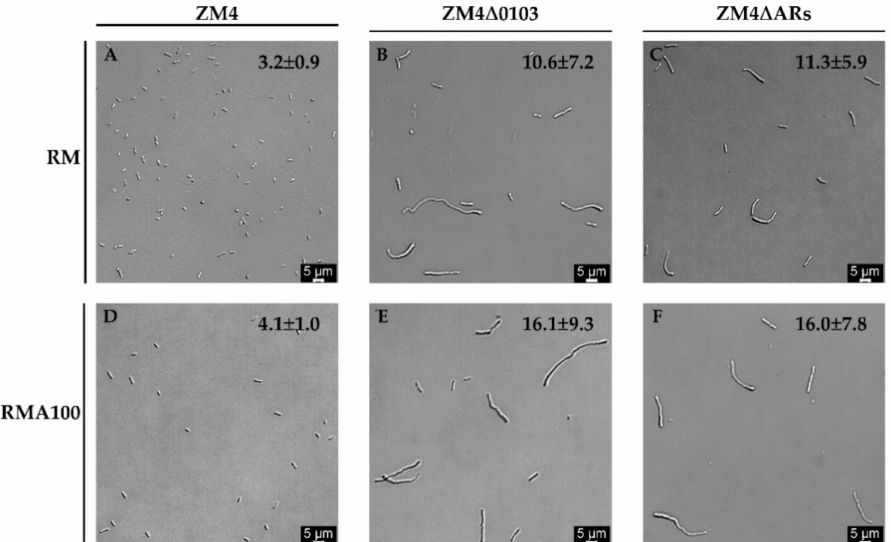
Figure 3. Cell morphology of strains ZM4, ZM4 ∆ 0103, and ZM4 ∆ ARs cultured in RM and RMA100 was observed by light microscopy. The numbers with error value in each image represent the average cell size ( µ m) analyzed with ImageJ software. Numbers in the lower right corner of each represent the scale. RM and RMA100 represent the different RMG5 media with 0 and 100 µ g/mL of